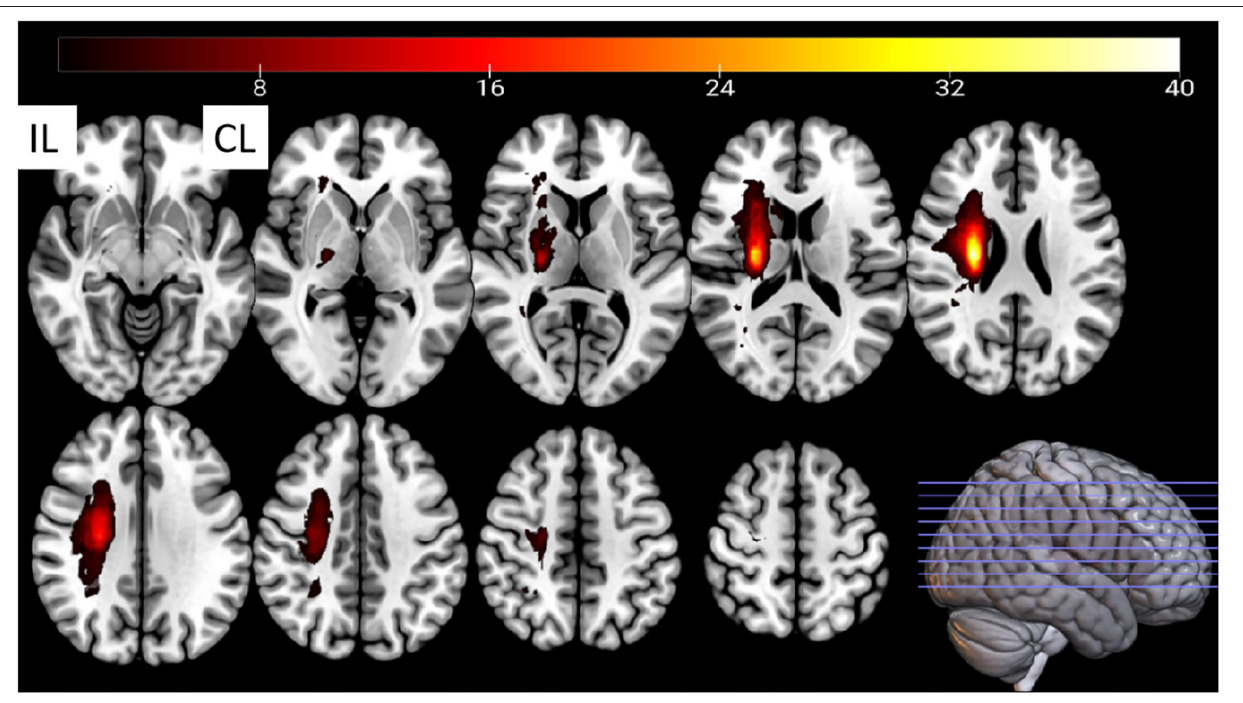
FIGURE 1 | The stroke patients’ lesion-incidence map. CL, contralesional; IL, ipsilesional. Fifteen lesions from the left hemisphere were flipped to the right